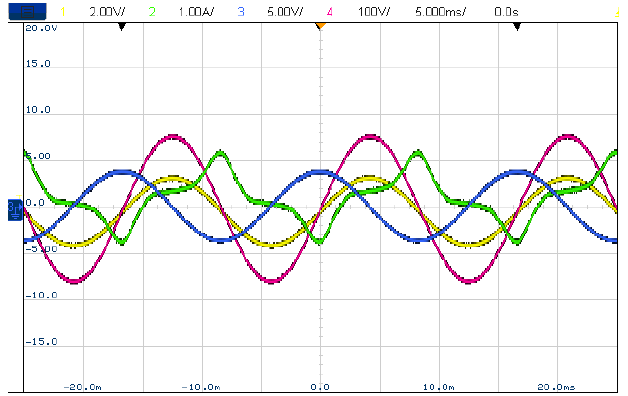
Figure 3. Integrator waveform diagram, where ch1 (yellow) is the attenuated voltage of the trans- former’s secondary-side, ch2 (green) is the transformer’s primary-side current, ch3 (blue) is the integrator output, and ch4 (red) is the transformer’s primary-side voltage. As shown in Figure 4a, the output signal of the integrator (integrated voltage) was reversed from that of the oscilloscope setting because of the polarity inversion of the integrator. The two signals of the primary current and integration of secondary voltage had a minor DC offset, which may have affected the B – H plot. As shown in Figure 4b, when the oscilloscope’s XY mode (Lissajous pattern) was used, an equal-ratio B – H curve was obtained. Specifically, the x- and y-axes were set as the current of the primary side and the output voltage of the integrating circuit, respectively. Additionally, the channel of the output voltage of the integrating circuit was inverted to have the same polarity as that of the input signal. The oscilloscope cannot be used to multiply the primary-side current and the output voltage of the integrator circuit by k H and k B as in Equations (3) and (4). Therefore, these coefficients were used only as references for relevant comparisons. As indicated by the DC offset, both the x- and y-axes shifted on the B – H